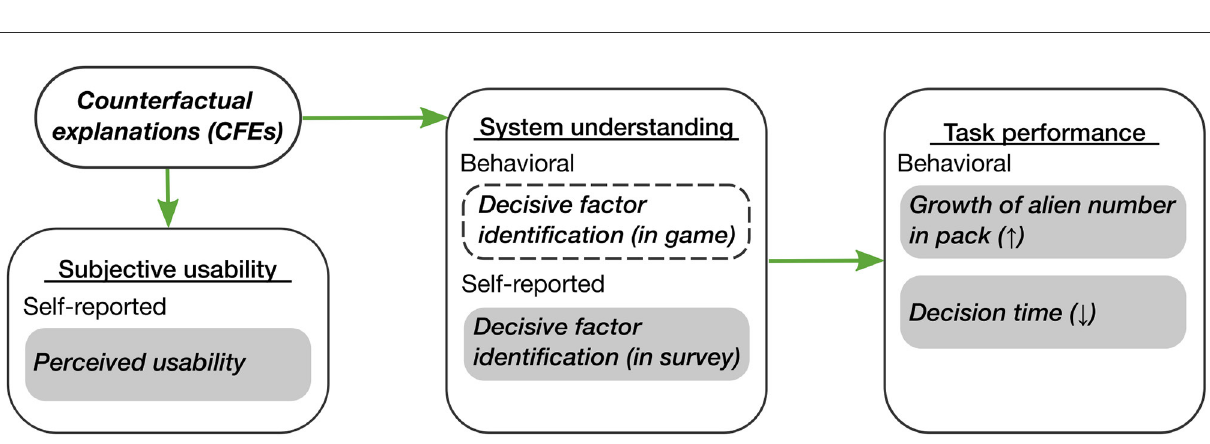
FIGURE2 Causal diagram describing expected effects of counterfactual explanations on the constructs subjective usability, system understanding, and task performance investigated in the Alien Zoo framework. Green arrows depict expected positive effects. Opaque gray boxes show the measures for the respective construct, divided into behavioral and self-reported measurements. Arrows behind measures depict the expected direction of positive effects. The dashed box shows a behavioral factor reflecting improved system understanding indirectly assessed via its mediating role on task